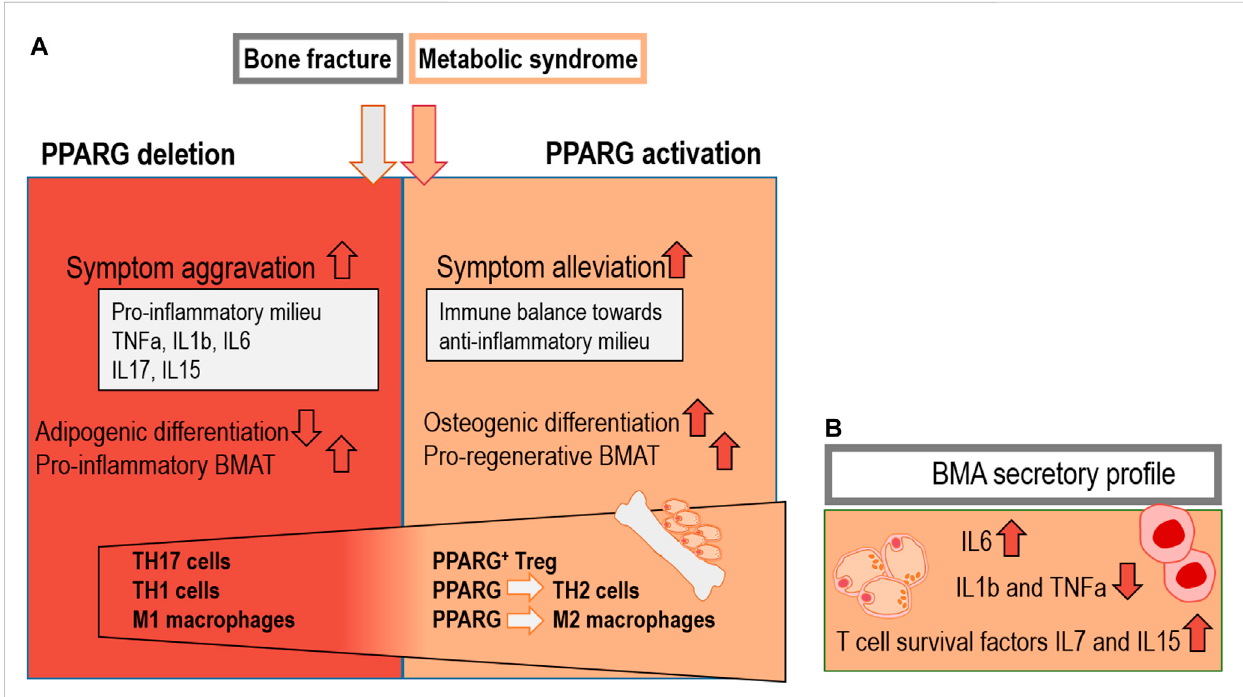
FIGURE 4 Combinedeffects ofPPARGdeletionandactivation inmetabolicsyndromeandbonefracture: (A) PPARGdeletionisshownto aggravate symptoms by the induction of pro-in fl ammatory cytokines such as TNFa, IL1b, IL6, IL17, and IL15, while reducing adipogenic differentiation. In fl ammatory T cells such as TH17 and TH1 TH cells as well as M1 macrophages can be induced by PPARG deletion. PPARG-driven TH2 cell differentiation as well as the induction of PPARG+ Treg and anti-in fl ammatory M2 macrophages has been proposed (Hontecillas and Bassaganya-Riera, 2007; Hontecillas and Bassaganya-Riera, 2007; Miller, 2011; Angela et al., 2016; Heming et al., 2018; Menn and Neels, 2018; Miggitsch et al., 2019). (B) BMAds show elevated levels of IL6 secretion and well-known T cell survival factors IL7 and IL15 as well as reduced levels of pro-in fl ammatory IL1b and TNFa. These cytokines can have a potential impact on T cells in the bone marrow microenvironment (Laharrague et al., 2000; Miggitsch et al.,